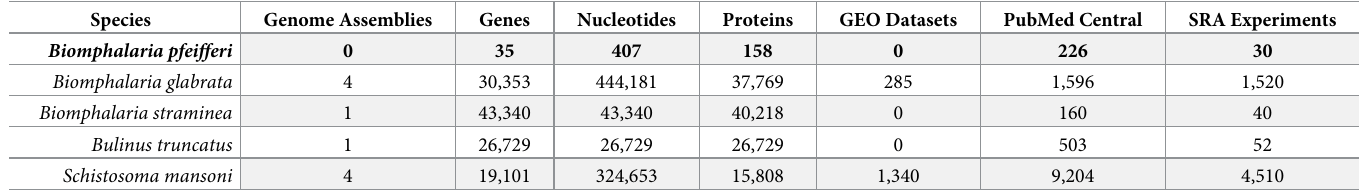
Table 1. Current B . pfeifferi genomic resources are limited as compared to some other relevant schistosome vector species, based on GenBank records, as of August 10, 2022.